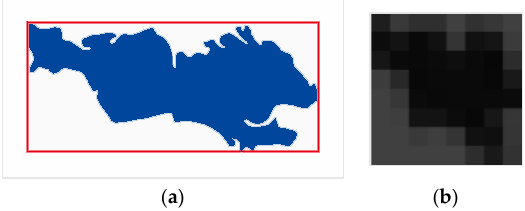
Figure 5. Global feature calculation. ( a ) Determine the calculation region; ( b ) Grayscale image.